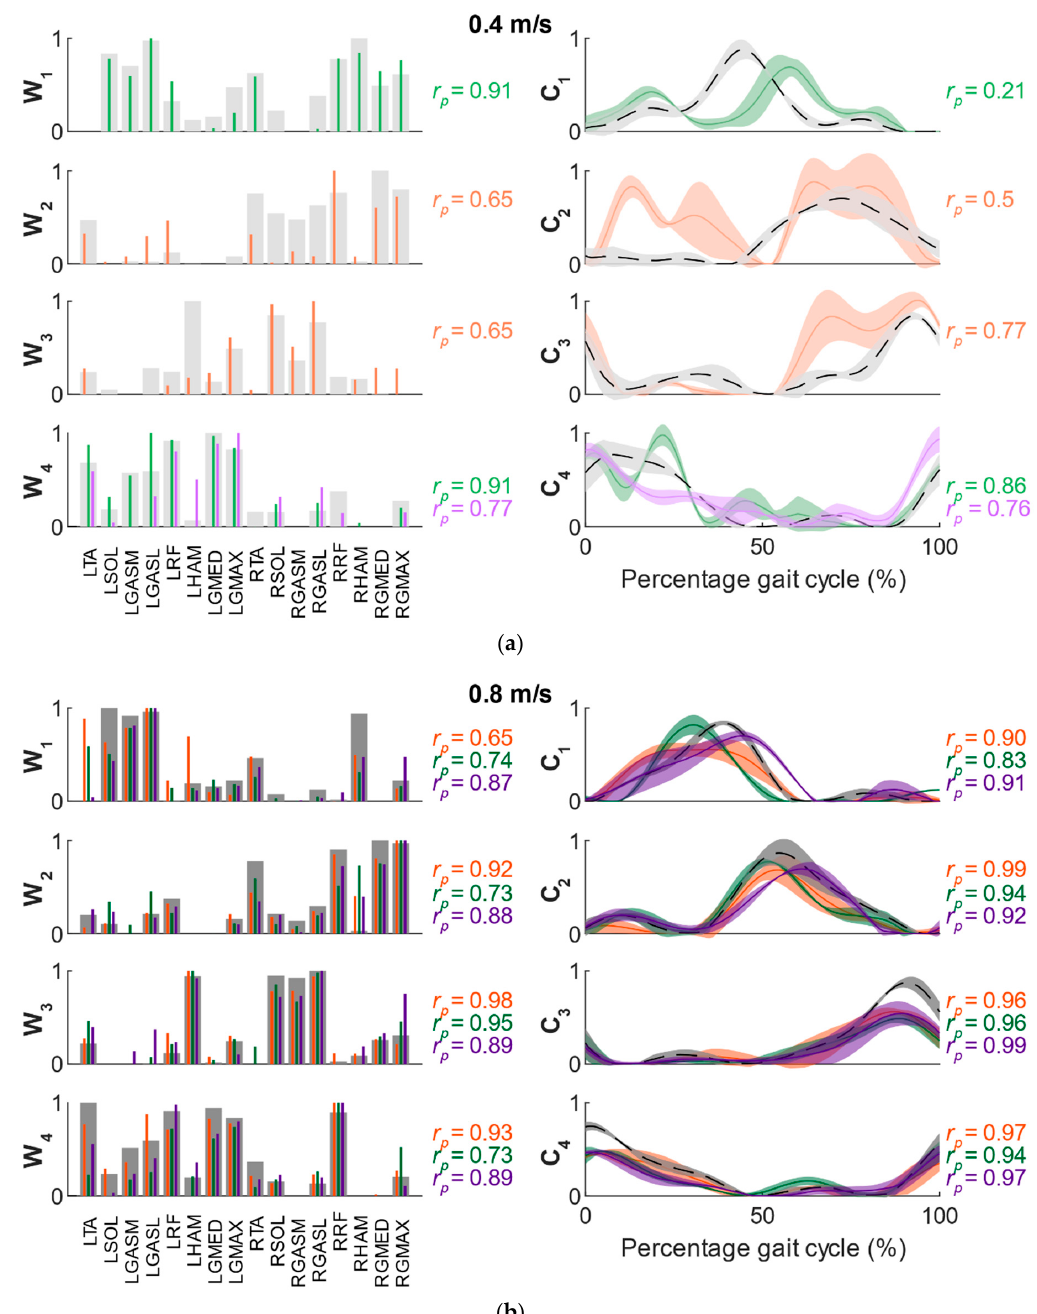
Figure 5. Muscle synergies and weighting curves for outward-directed perturbed walking and unperturbed walking at ( a ) the lowest and ( b ) the fastest walking speed for a representative subject. The colors indicate unperturbed walking (grey) and perturbed walking, with a perturbation onset of 0% (orange), 30% (green), or 60% (purple) of the stance phase of the gait cycle. ( left ) Muscle synergies for unperturbed (wide grey bars) and outward-directed perturbed walking for different perturbation onsets (narrow colored bars). Muscle synergies for perturbed walking were only shown when similar to the corresponding muscle synergy for unperturbed walking ( r p ≥ 0.623). ( right ) Weighting curves for unperturbed (black striped line) and perturbed walking with different perturbation onsets (colored solid lines). Weighting curves are displayed as the mean value (lines) ± standard deviation (shaded area) of three